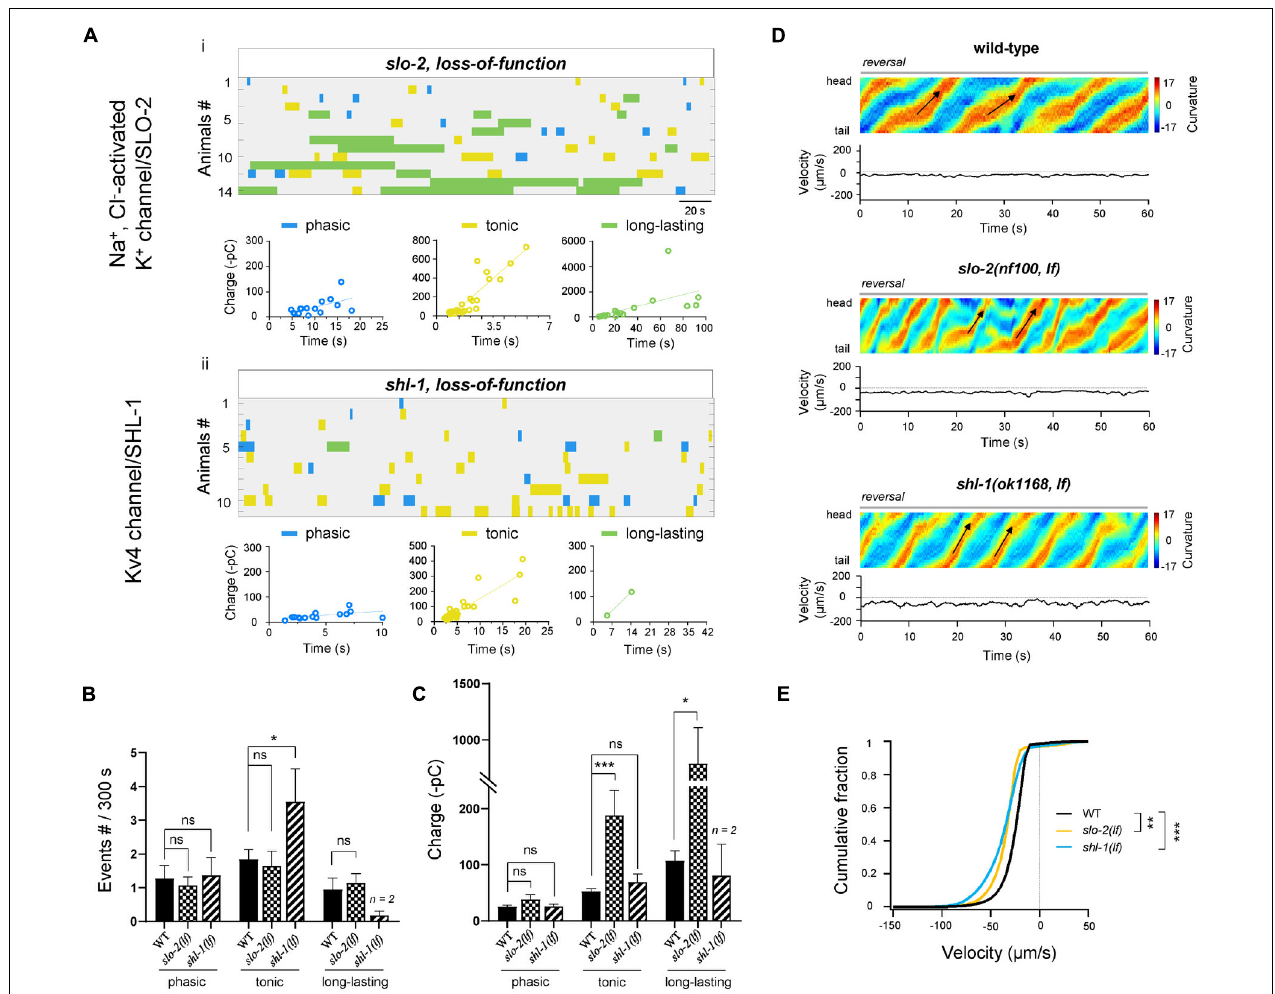
FIGURE 6 | K Na /SLO-2 and Kv4/SHL-1 channels differentially regulate tonic- and long-lasting-type rPSCs. (A) Colormap and charge efficiency (linear fitting) of all rPSC events recorded from ablated slo-2(nf100; lf) and shl-1(ok1168; lf) mutant animals, respectively. Blue dots denote phasic-type events, yellow dots denote tonic-type events, and green dots denote long-lasting-type events. (B,C) Quantification of the frequency and charge of different rPSCs in respective genotypes. n ≥ 11 animals in each group. Only 2 long-lasting-type rPSCs events were recorded in shl-1(lf) mutants. (D) Representative curvature kymogram ( up ) and instantaneous velocity ( bottom ) of free-behaving animals of respective genotypes. Ablated slo-2(nf100; lf) and shl-1(ok1168; lf) animals exhibit increased reversal, as posterior to anterior propagating body bends (arrows). (E) Distribution of instantaneous velocity of wild-type, slo-2(nf100; lf), and shl-1(ok1168; lf) mutant animals. The velocity fraction is drastically left-shifted both in slo-2(nf100; lf) and in shl-1(ok1168; lf) mutant animals. n ≥ 10 in each group. ** P < 0.01, *** p < 0.001 against ablated wild-type by the Kolmogorov–Smirnov test. All data are expressed as means ± SEM. Student’s t -test was used (B,C) . Statistical significance is indicated as follows: ns, not significant, * p < 0.05, *** p < 0.001 in comparison with that as